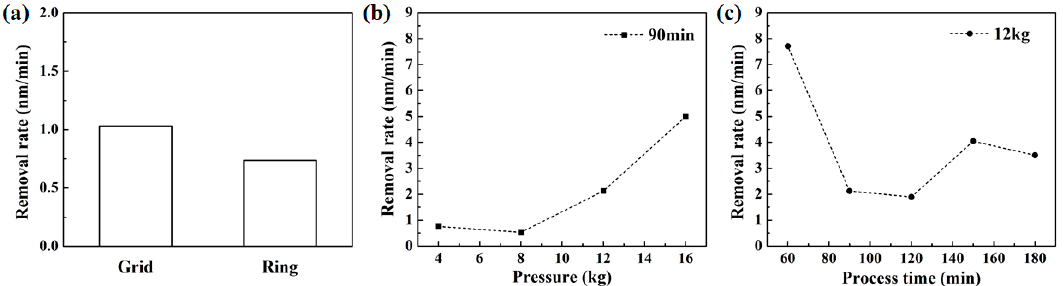
Figure 8. Material removal rates (MRR) of sapphire lapped by plates ( a ) with concentric circles and grid patterns, ( b ) with grid patterns under variable lapping force, and ( c ) time histories of MRR of sapphire lapped with grid patterns under lapping force of 12 kg.